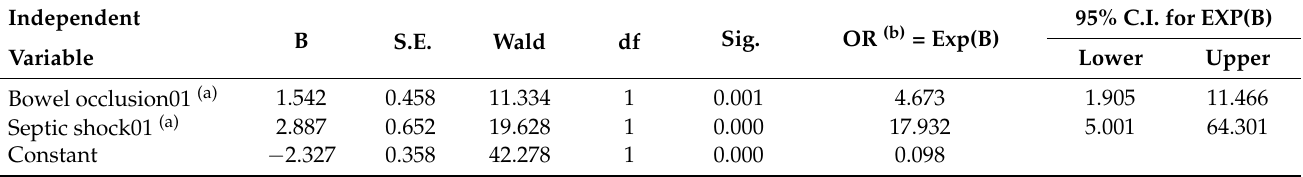
Table 4. Logistic regression model for dependent variable